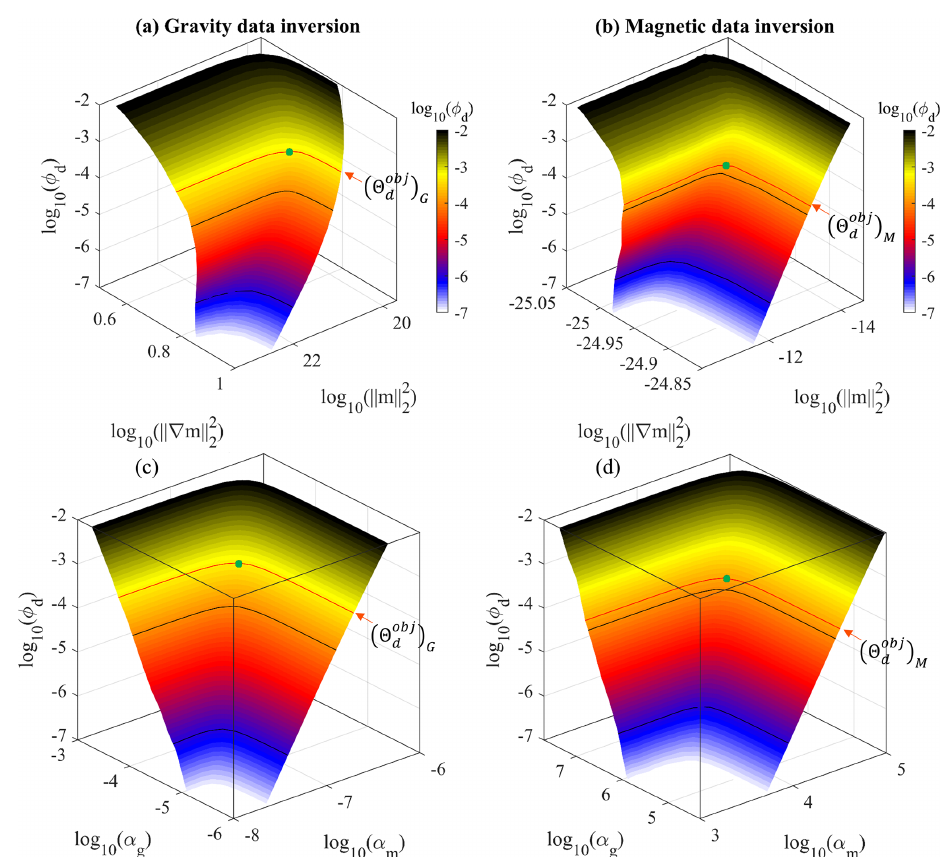
Figure 9. Elbow surfaces for gravity and magnetic inversions (top row) and a plot of the data misfit term as a function of the α weights (bottom row). Each plot uses a total of 1260 points sampling the ( α m ,α g ) plane. The black lines show the contour values corresponding to the ticks shown in the palette’s colour bar, which shows the value of the data misfit term. The red line materialises the contour value of (cid:50) obj guiding the selection of the optimum ( α m , α g ) values, and the green dot materialises the vicinity of the curve’s inflection point.